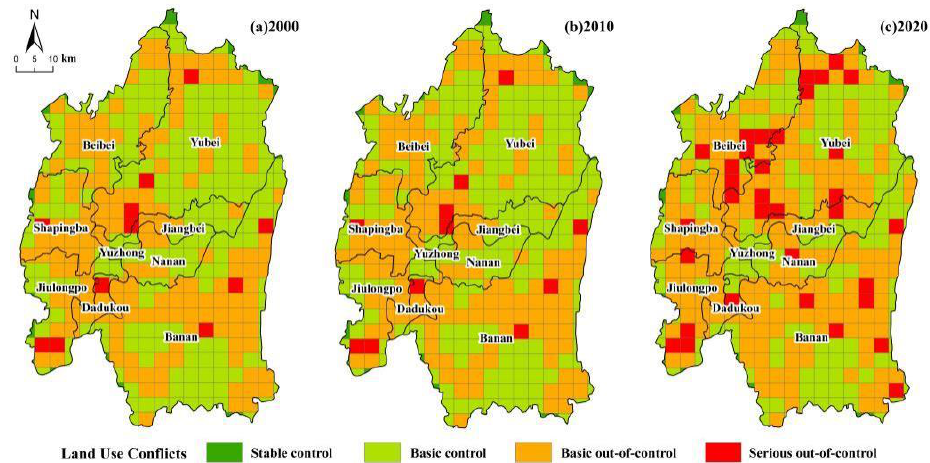
Figure 5. Spatial – temporal distribution characteristics of the LUCs from 2000 to 2020 . Figure 5. Spatial-temporal distribution characteristics of the LUCs from 2000 to 2020.